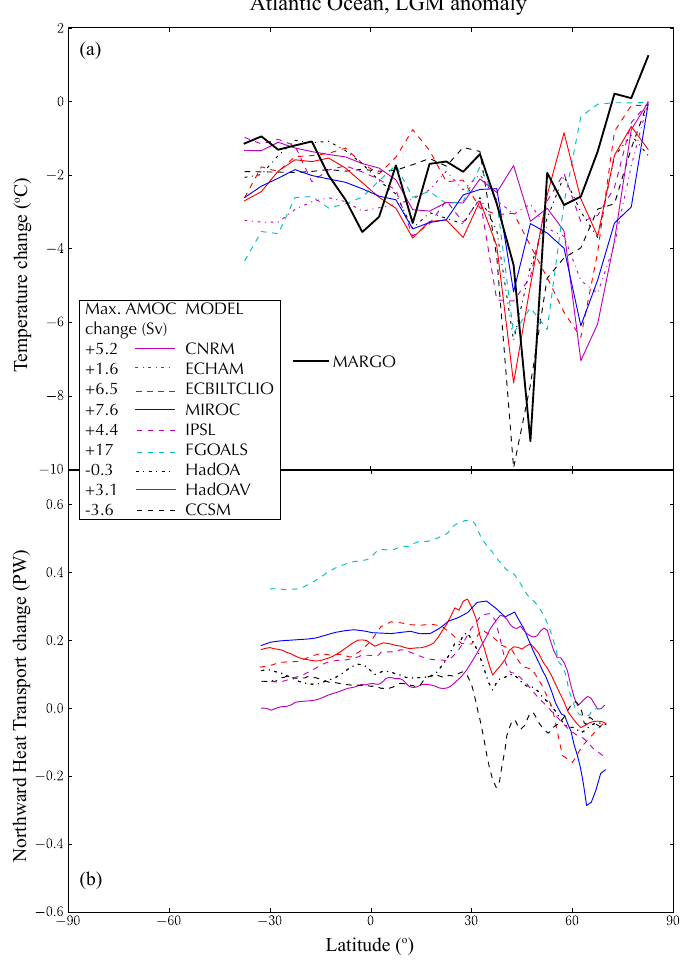
Fig. 9. PMIP2 and MARGO for the Atlantic ocean, zonal averages over the MARGO grid points: (a) SST; (b) Northward Heat Transport. The NHT is cutoff at 30 ◦ S, as further south some of the model outputs appear to include data from other ocean basins. The values of the LGM anomaly of the AMOC maximum are listed in the order of the magnitude of the minimum in the LGM SST anomaly around 40–50 ◦